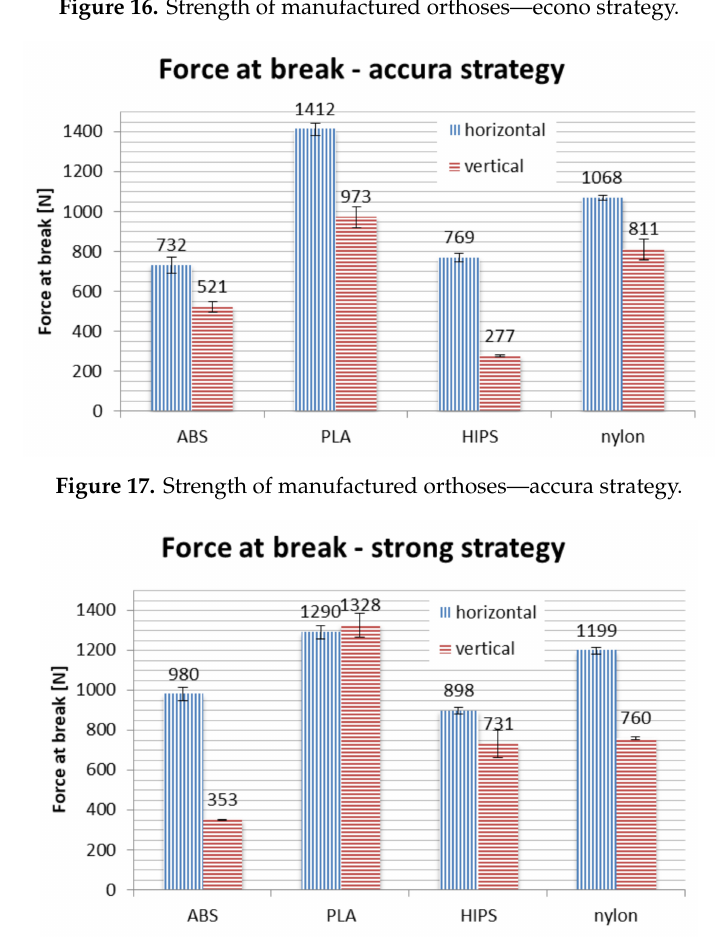
Figure 18. Strength of manufactured orthoses—strong